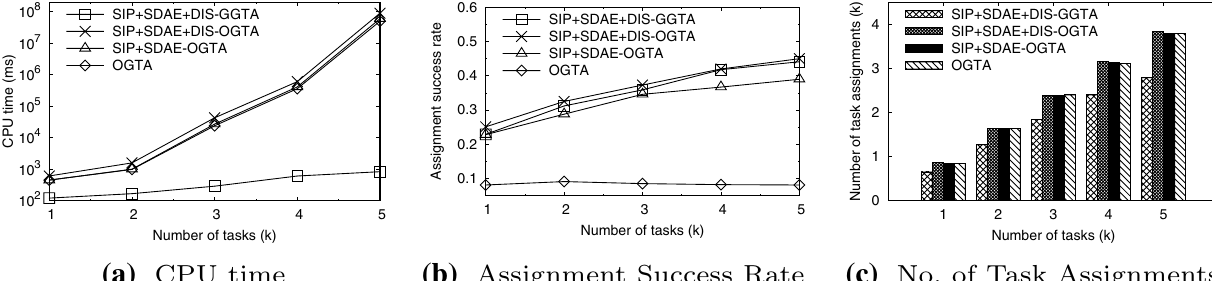
Fig. 13 Performance of group task assignment: effect of | S